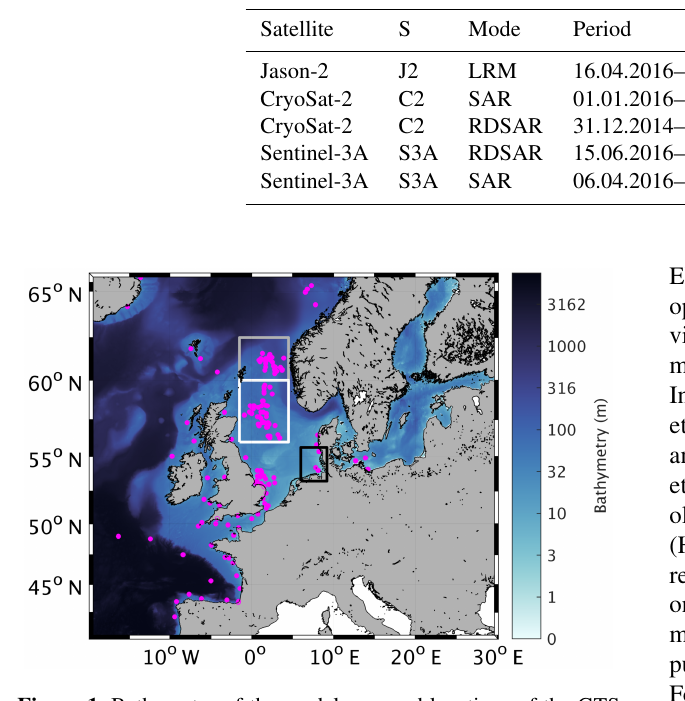
Figure 1. Bathymetry of the model area and locations of the GTS measurements. The boxes indicate the area of the German Bight (black) and the GTS measurements in the northern part of the North Sea used for the comparisons in Sect. 3.2.1 and 3.2.3 (grey and